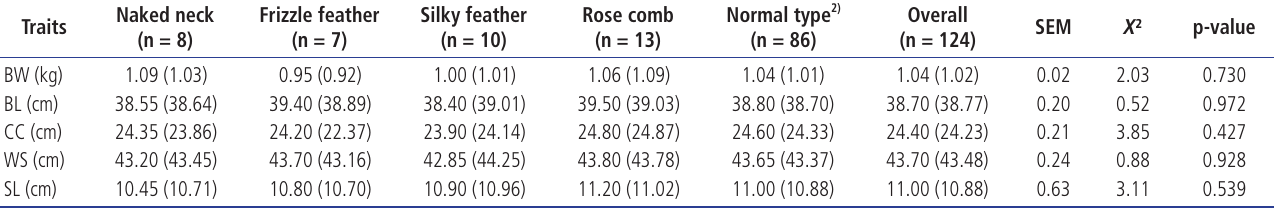
Table 4. Medians (means in parentheses) of morphometric traits measured in male local chicken phenotypes 1)